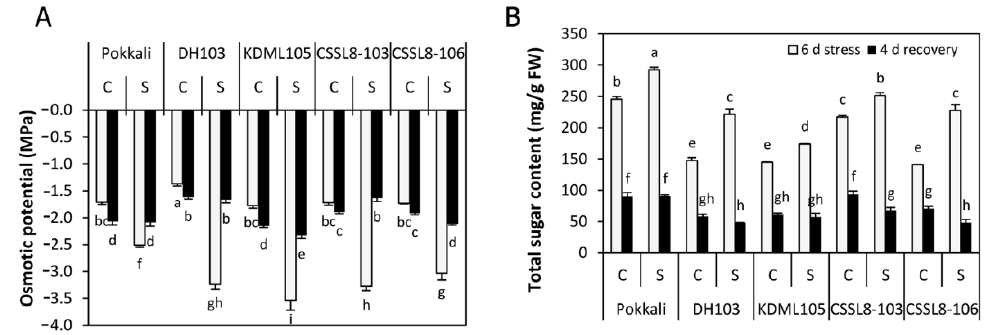
Figure 4. ( A ) Osmotic potential and ( B ) total sugar content of rice plants under control and salt stress for 6 days (light gray bars) and after recovery for 4 days (black bars). C, control; S, salt stress. For a description of the genotypes, see Figure 1. Values are means of four replications ± SE. Different letters indicate a significant difference in the means of each group ( p ≤ 0.05).